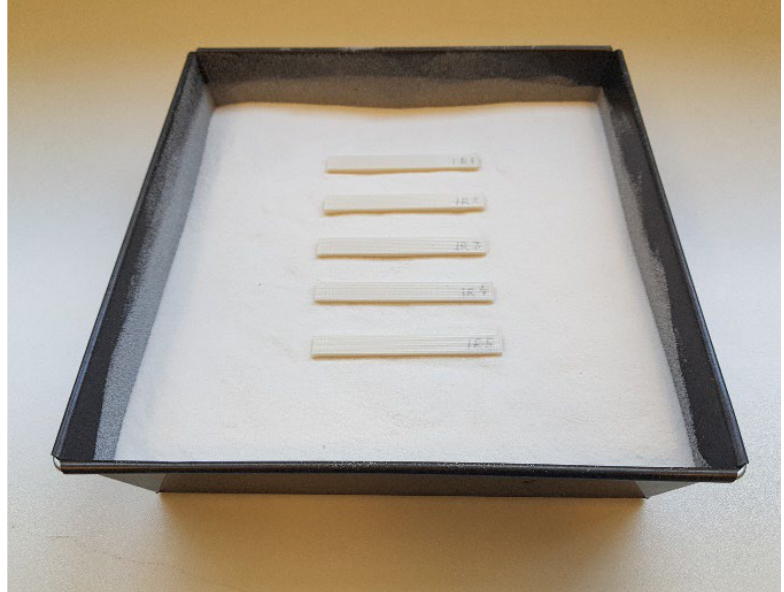
Figure 2. Sample of 5 specimens placed inside the mould.